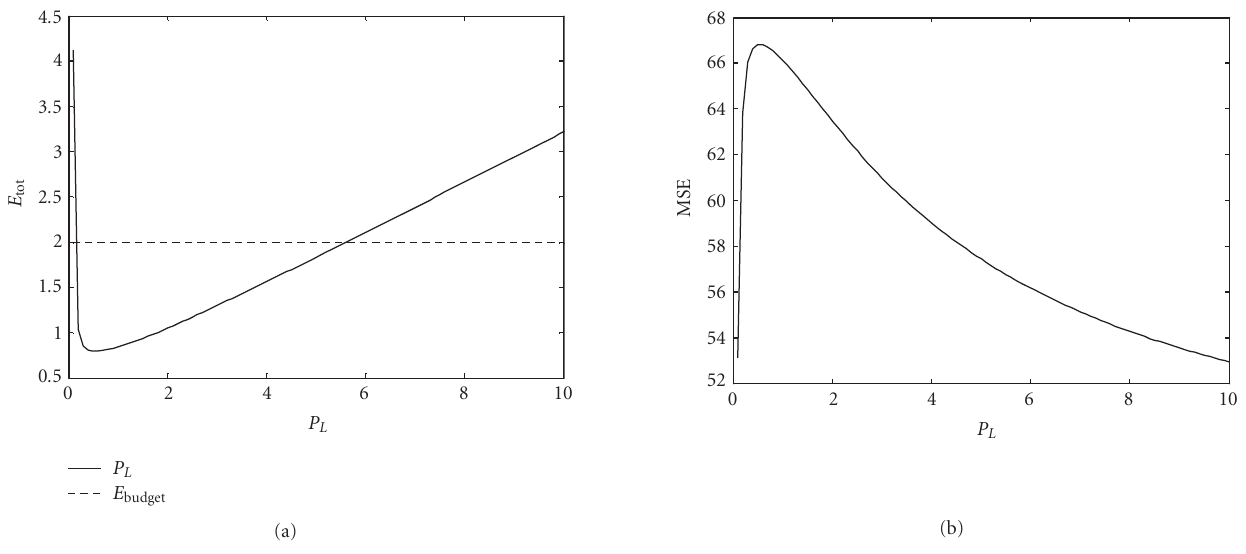
Figure 7: Foreman QCIF sequence, frame 10, equal-size packets: (a) total energy E tot (J) and (b) frame distortion (MSE) (dB) versus the power of the last packet, P L (W). In (a), the dotted line represents the energy